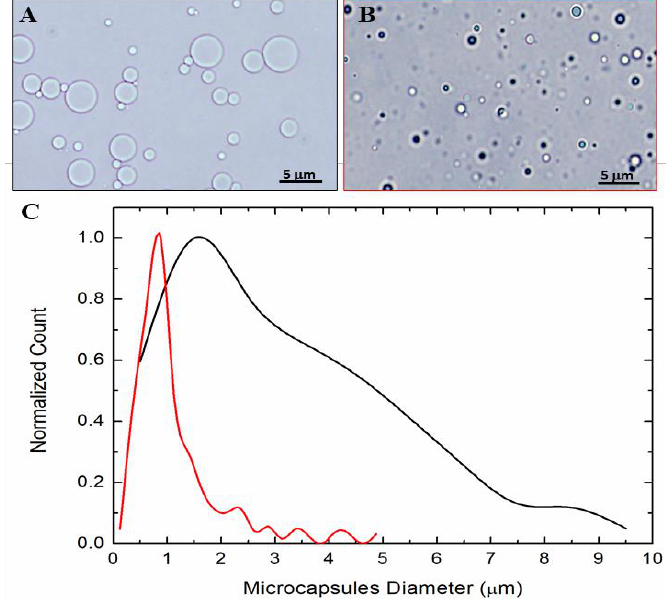
Molecules 2021 , 26 , 5157 10 of 13 Figure 9. (A , B ) Optical microscopy images of PG mc embedding soybean oil and VitD, respectively. ( C ) Size distribution of PG mc with soybean (black) and PG mc with VitD (red). Overall, there results indicate that phytoglycogen nanoparticles with a large size and a low protein content are not effective for the encapsulation of oily phases.